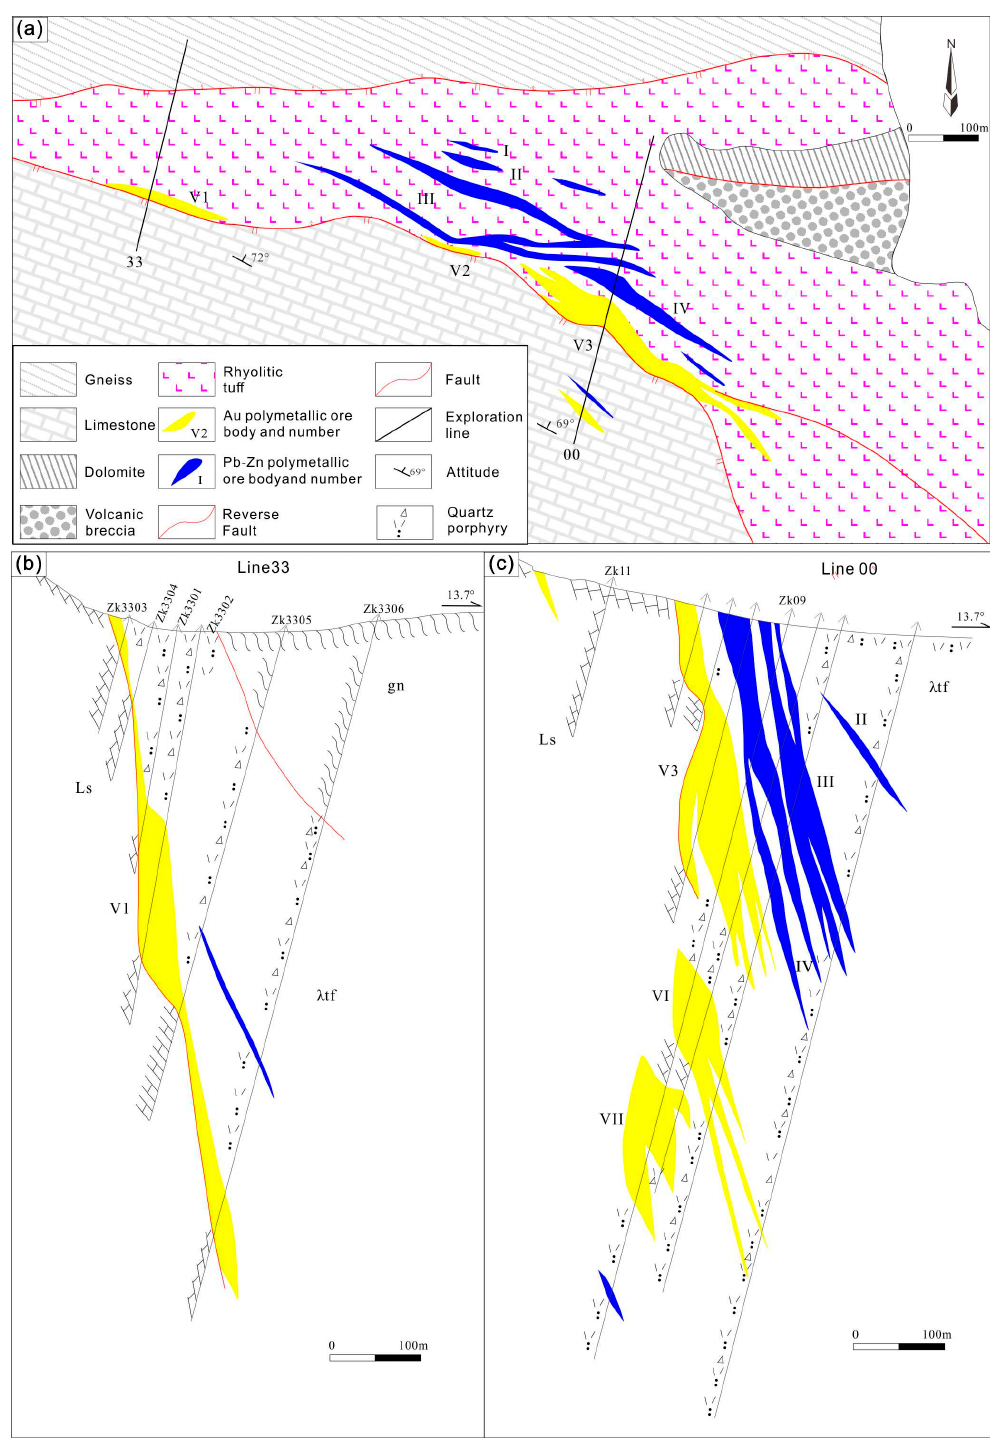
Figure 2. ( a ) Geological map, geological cross sections along exploration lines ( b ) No. 33 and ( c ) No. 00 of the Kengdenongshe polymetallic deposit (modified after Reference [14]). Ls: Limestone; λ tf: Rhyolitic tuff; gn: gneiss. Ⅱ : Number of ore body.